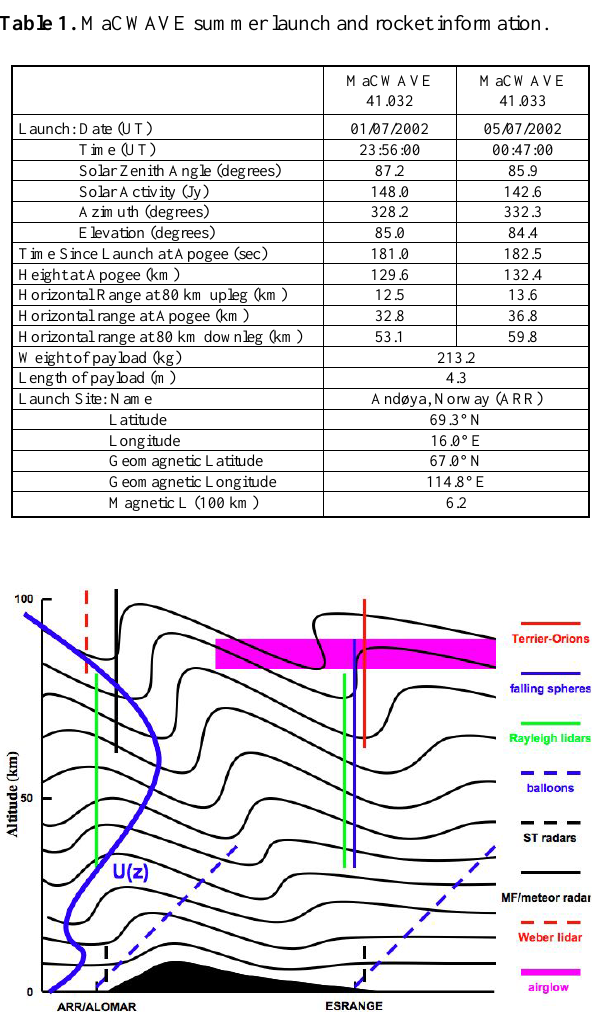
Fig. 4. Artist’s representation of the MaCWAVE winter program. The WEBER lidar refers to the Na lidar at